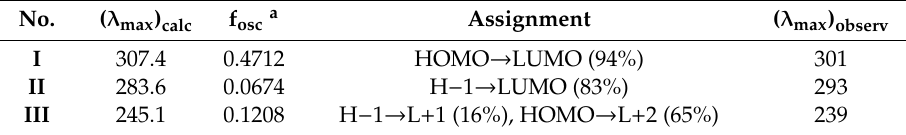
Figure 12. The experimentally observed bands were calculated at 245.1 nm (f = 0.1208), 283.6 nm (f = 0.0674), and 307.4 nm (f = 0.4712), respectively. The complete assignments of the molecular orbitals